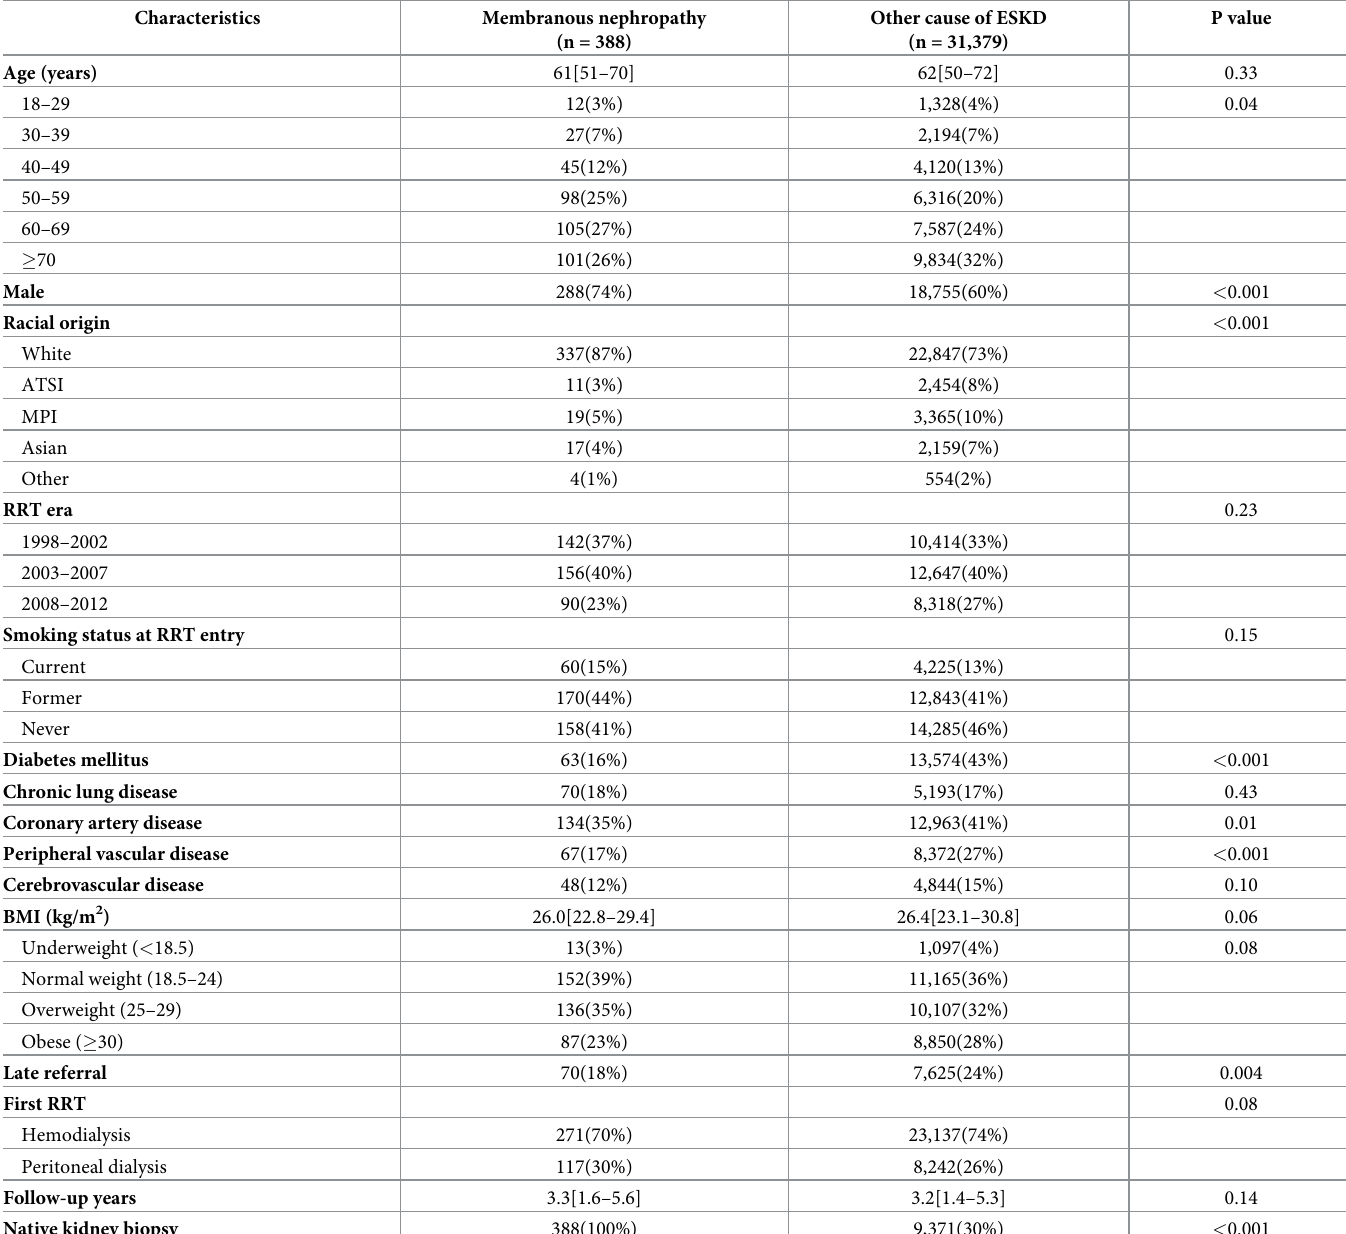
Table 1. Characteristics of ESKD patients whose first RRT was dialysis in Australia and New Zealand.